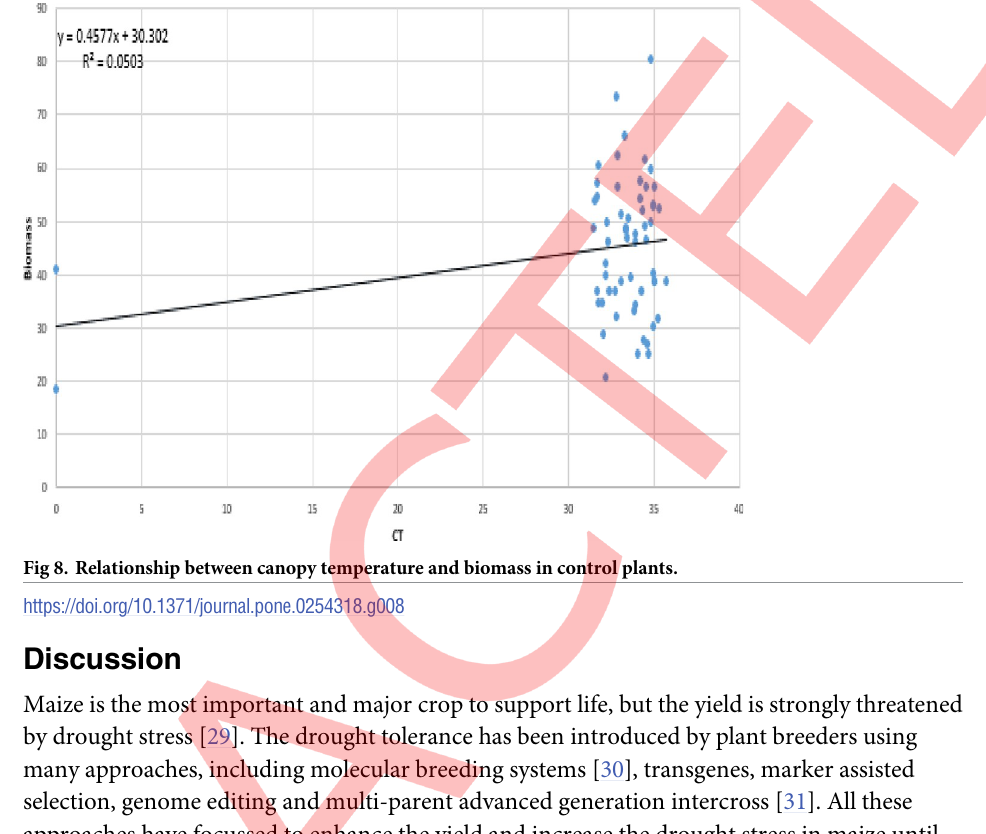
Fig 8. Relationship between canopy temperature and biomass in control plants.